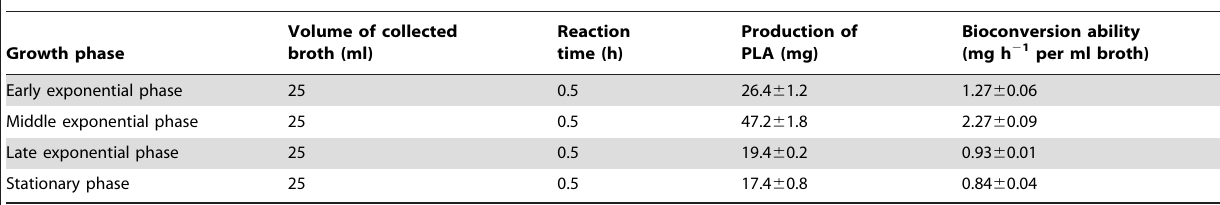
Table 1. Effects of cell growth phase on PLA production a .